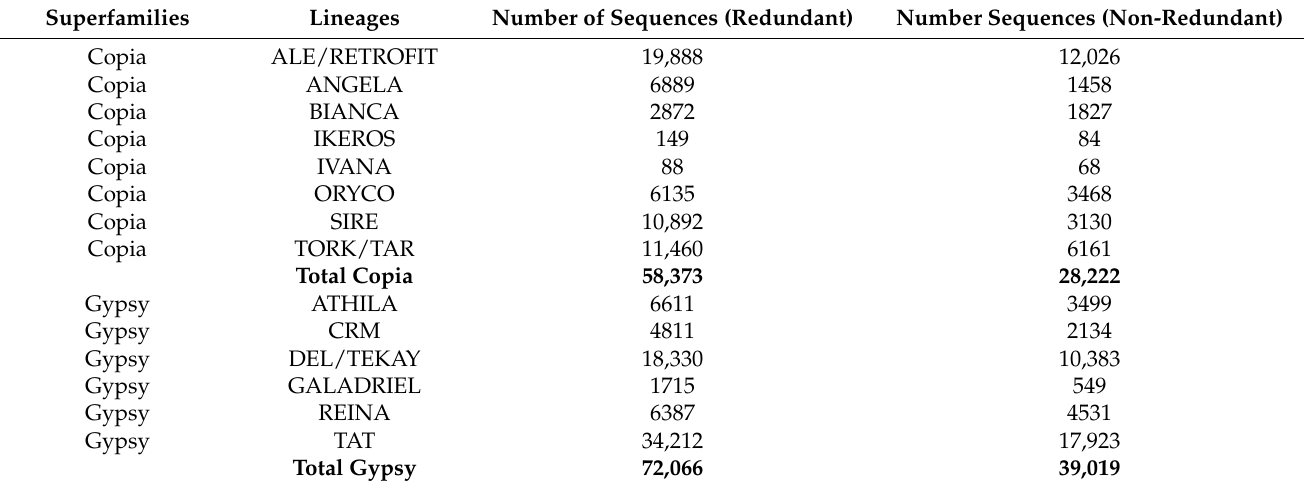
Table 3. Number of elements for each lineage in the non-redundant version of InpactorDB.